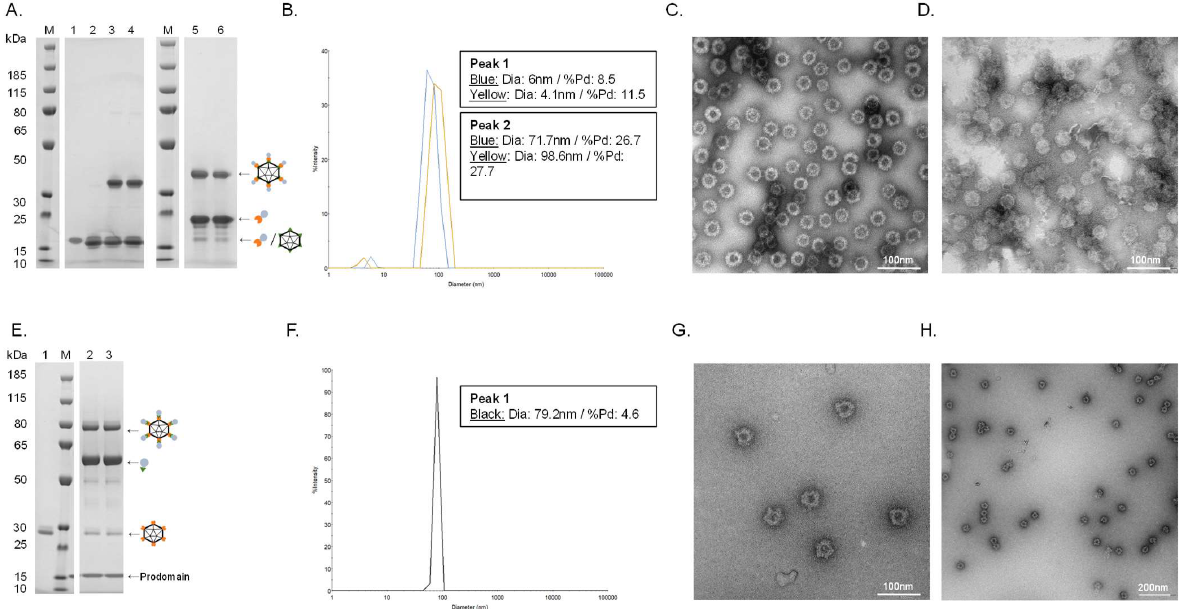
Figure 2. Vaccine quality assessment. ( A ). Individual vaccine component and resulting coupling band on a reduced SDS-PAGE gel. M: marker, lane 1: unconjugated SpyT-cVLP (16.5 kDa), lane 2: unconjugated SpyC-PCSK9(210–226) (15.5 kDa), lane 3: cVLP-PCSK9(210–226) after coupling over- night at 4 °C (32 kDa), lane 4: cVLP-PCSK9(210–226) after coupling overnight at 4 °C (32 kDa) + centrifugation test, lane 5: cVLP-PCSK9(156–227) after coupling overnight at 4 °C (38.5 kDa), lane 6: cVLP-PCSK9(156–227) after coupling overnight at 4 °C (38.5 kDa) + centrifugation test. ( B ). DLS analysis, showing a histogram of the % intensity of purified cVLP-PCSK9(210–226) (blue) and cVLP- PCSK9(156–227) (yellow) particles. The average diameter and polydispersity (%Pd) are annotated for each peak. ( C ). TEM image of negatively stained purified cVLP-PCSK9(210–226). ( D ). TEM im- age of negatively stained purified cVLP-PCSK9(156–227). ( E ). Individual vaccine component and resulting coupling band on a reduced SDS-PAGE gel. M: marker, lane 1: unconjugated SpyC-cVLP (27 kDa), lane 2: cVLP-PCSK9(FL) after coupling overnight at 4 ◦ C (86 kDa), lane 3: cVLP-PCSK9(FL) after coupling overnight at 4 ◦ C (86 kDa) + centrifugation test. ( F ). DLS analysis, showing a histogram of the % intensity of the purified cVLP-PCSK9(FL) particles. The average diameter and polydispersity (%Pd) are annotated. ( G , H ). TEM image of negatively stained purified